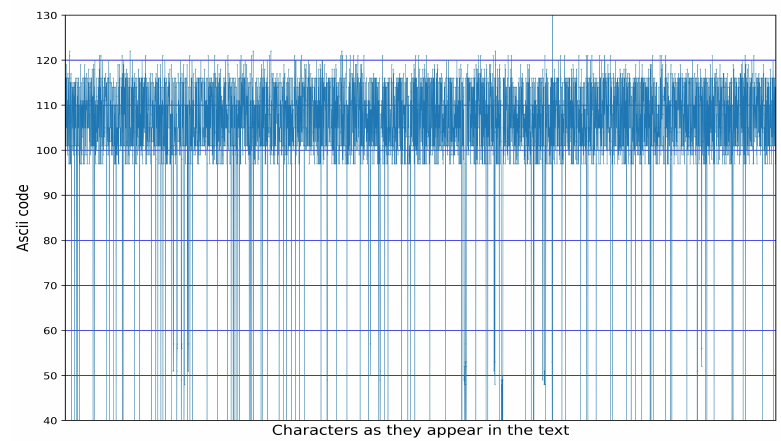
Figure 1. Resultant time series of the text that appear in [4] after it is mapped into ASCII